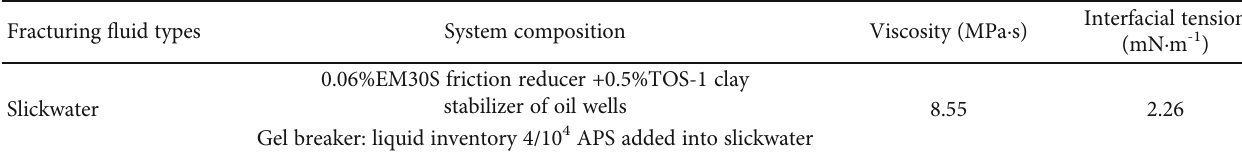
Table 1: Slickwater fracturing fl uid formula and fi ltrate